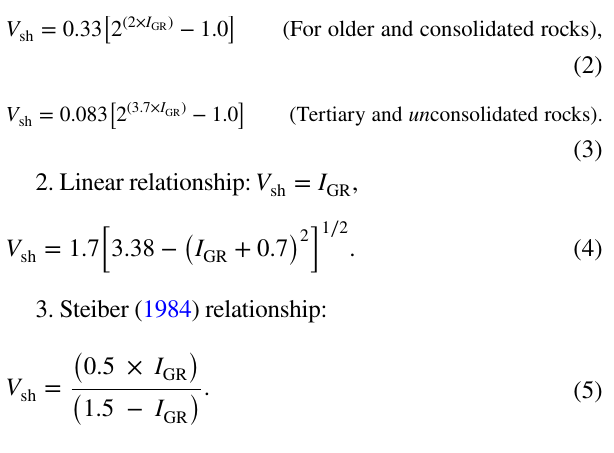
Fig. 5 Composite well logs and lithologic interpretation of well